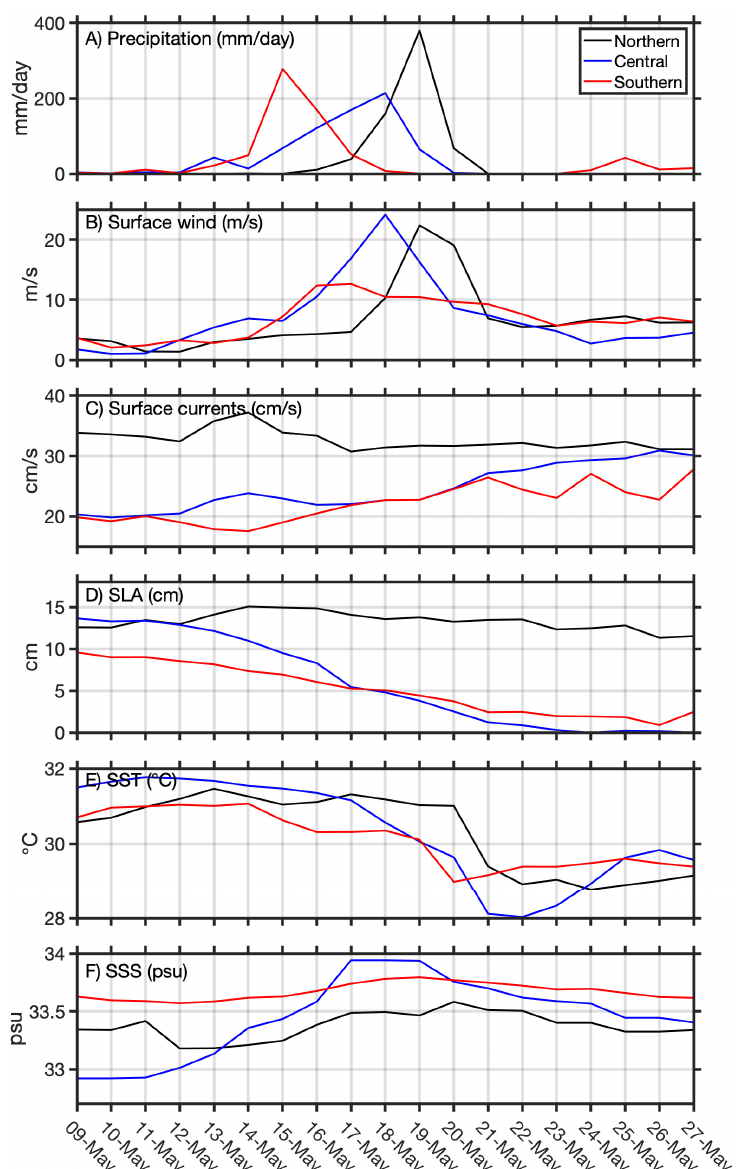
Figure 6. Box-averaged time series from May 9 to May 27, 2020 in the northern (86–88°E, 15–20°N; black), central (86–88°E, 10–15°N; blue), and southern (86–88°E, 5–10°N; red) Bay of Bengal for ( a ) GPM precipitation (mm/day); ( b ) CCMPv2 surface wind magnitude (m/s); ( c ) CMEMS geostrophic surface currents (cm/s); ( d ) CMEMS SLA (cm); ( e ) OISST (°C); and ( f ) SMAP SSS (psu).